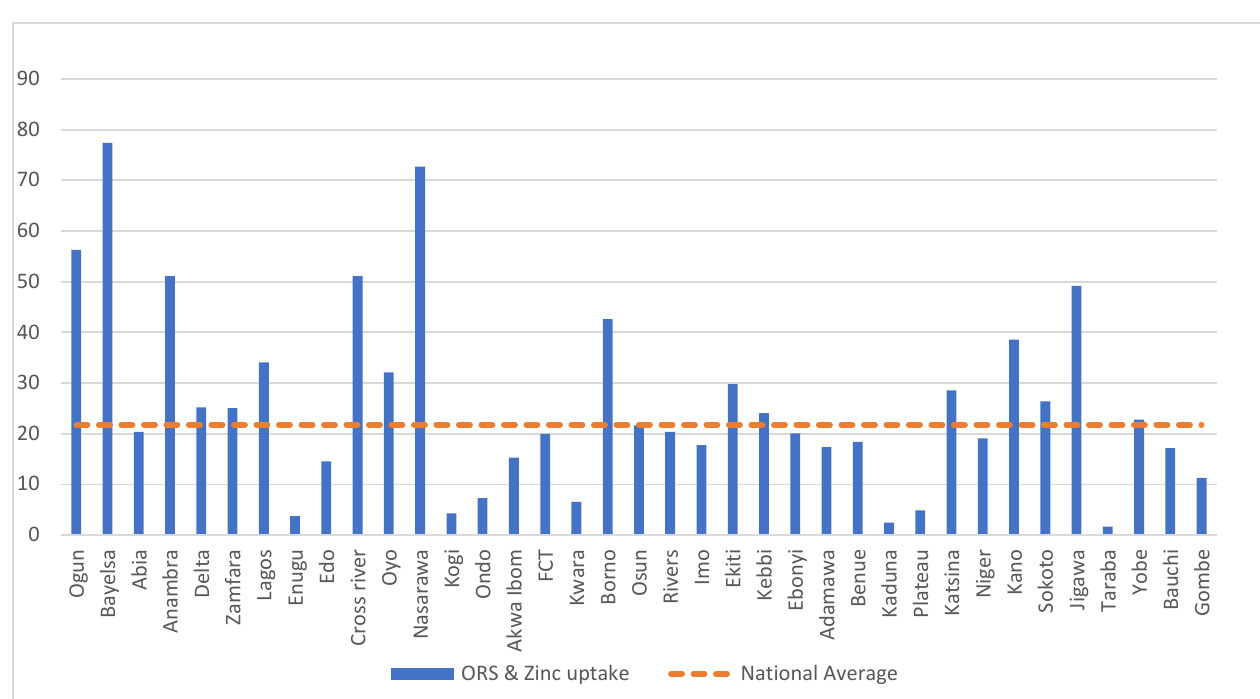
Figure 2. Percentage of children with diarrhea during the 2 weeks prior to the survey that were reported to have received zinc supplements by state compared to the national average of 29.1%.